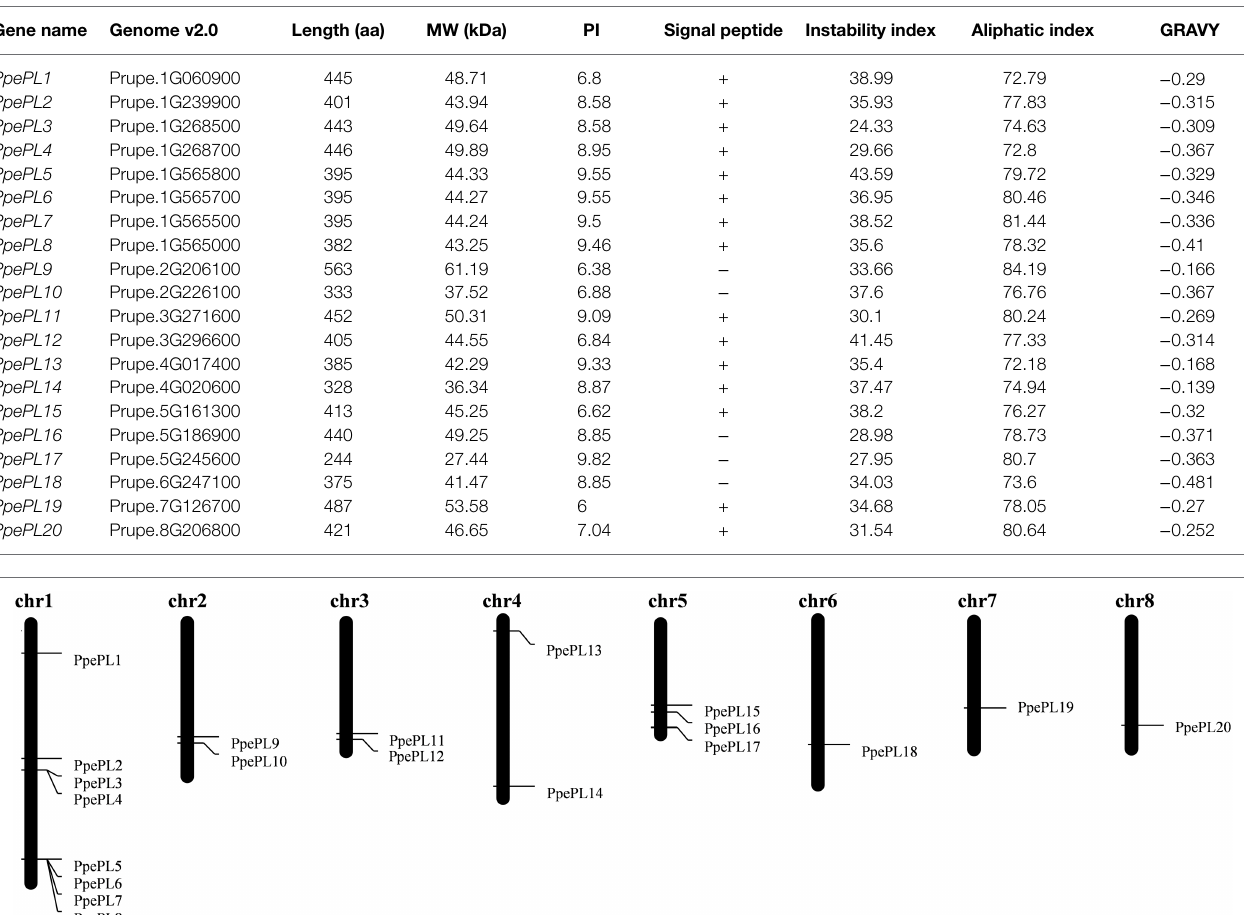
TABLE 1 | PpePL gene family with their molecular